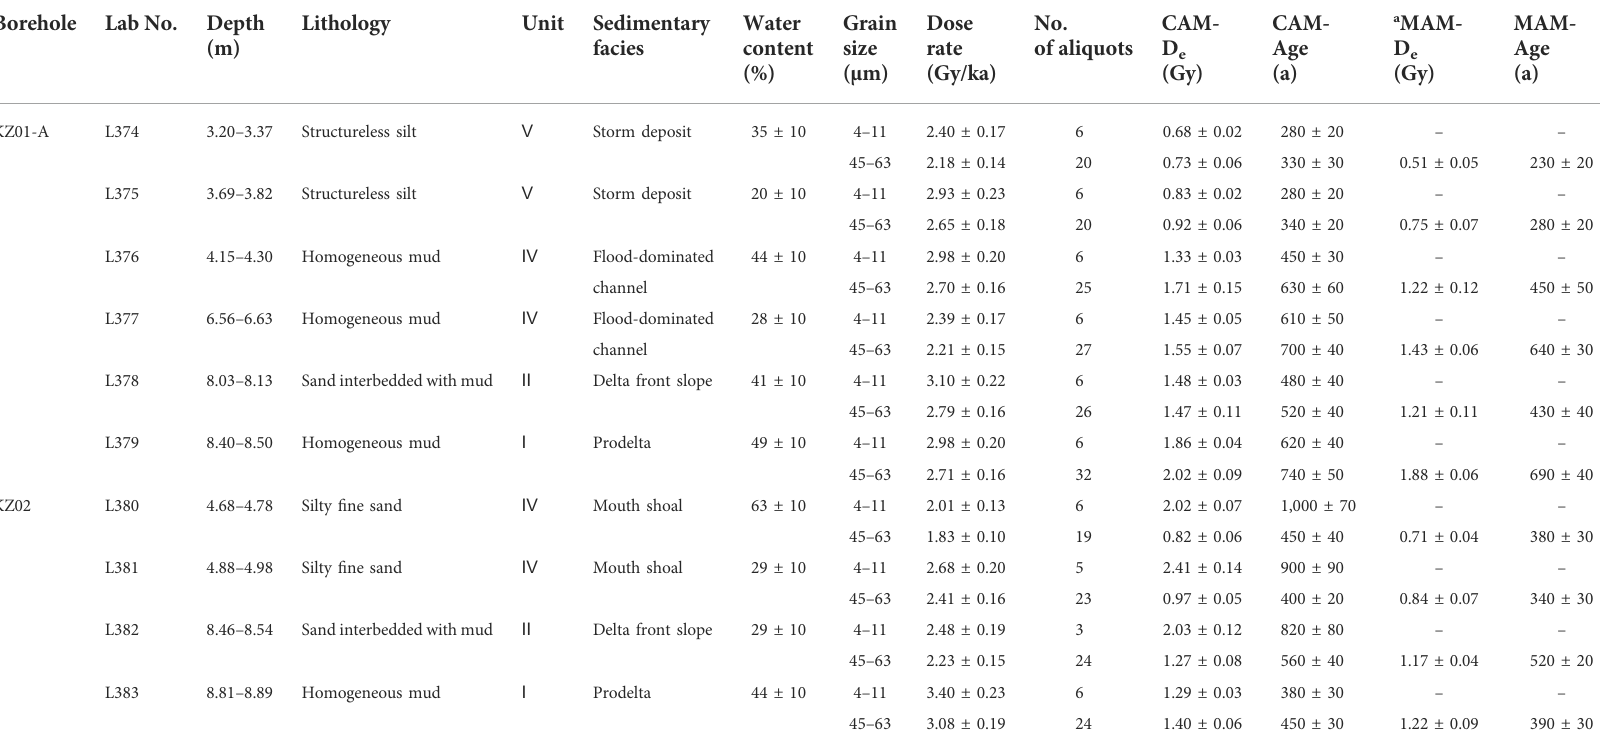
TABLE1Summaryof fi ne-grained(4 – 11 μ m)quartzOSLdatingresultsinthisstudyandperviouspublishedOSLdataofmedium-grained(45 – 63 μ m)quartz(Niuetal.,2021)incoresKZ01-AandKZ02.OSL ages are relative to 2017 CE.